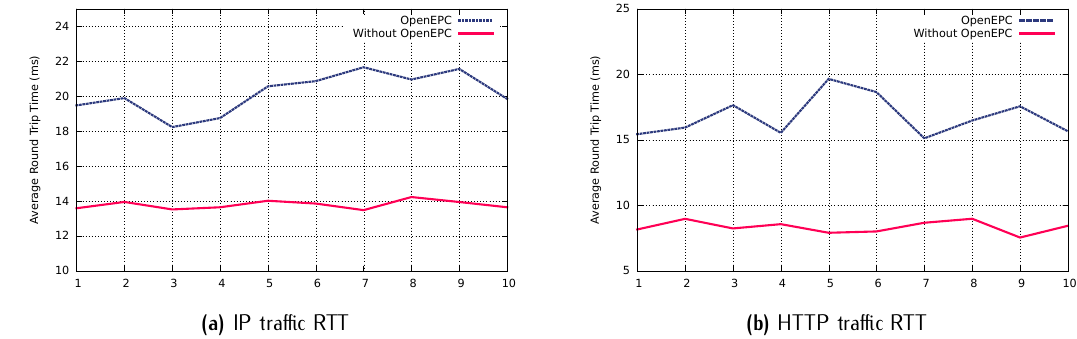
Figure 8. Average RTT between LTE/EPC network using OpenEPC and direct internet access network.